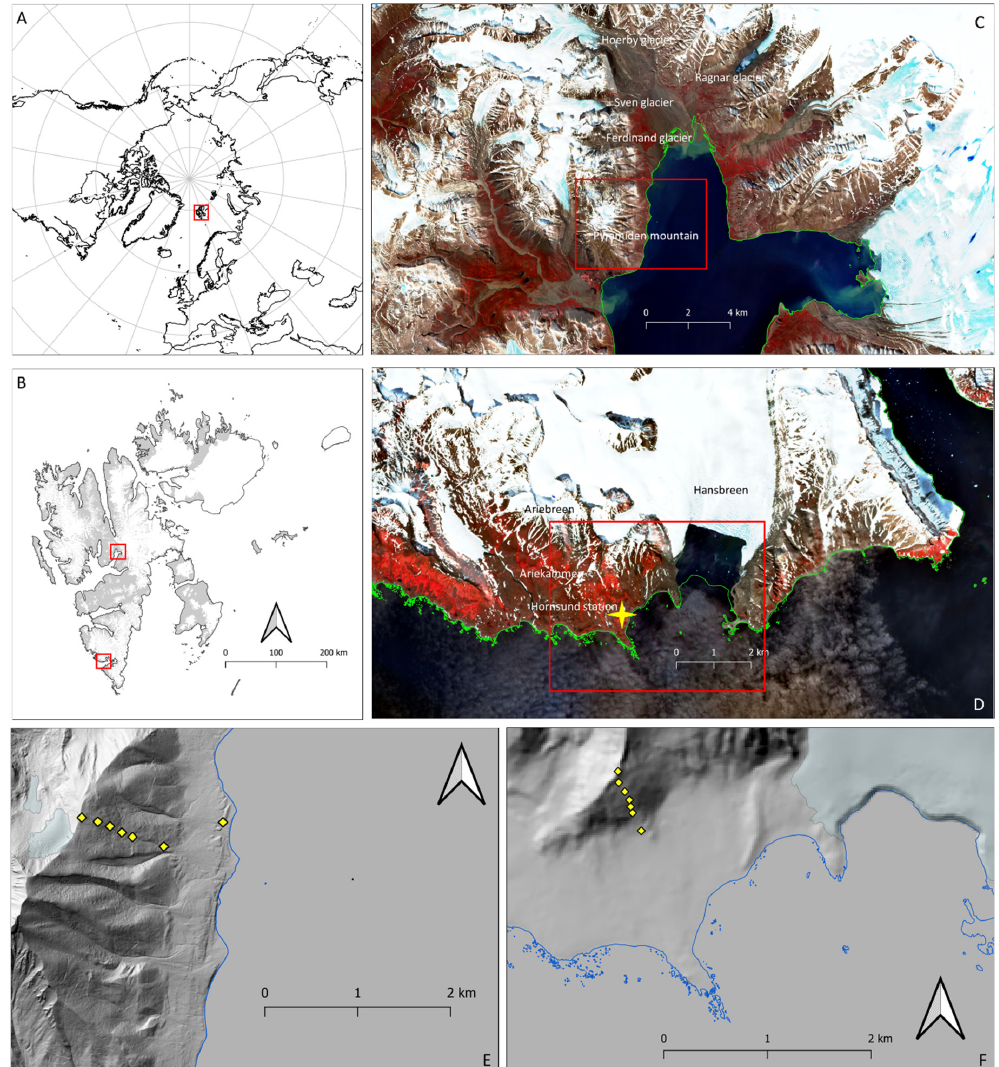
Figure 1. Location of Svalbard archipelago (red) ( A ); Svalbard with the two study sites marked with a red rectangle ( B ); Sentinel 2 image of the Pyramiden study site taken on 4 July 2019 with the study area in E marked with a red rectangle ( C ); Sentinel 2 image of the Ariekammen study site taken on 23 June 2019 with the study area in F marked with a red rectangle ( D ); detailed topography of the sampling sites on the Pyramiden mountain with sampling sites marked in yellow rectangles (DEM from 2009–NPI) ( E ); and detailed topography and sampling sites on the slope of the Ariekammen mountain with sampling sites marked in yellow rectangles (DEM from 1990–NPI) ( F